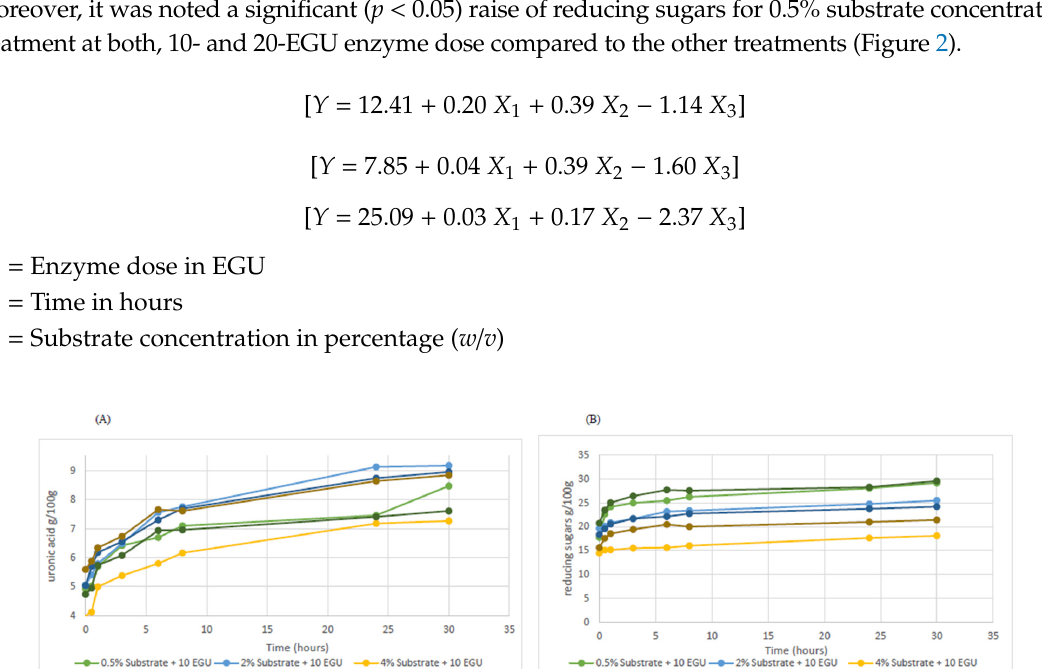
Figure 2. Determination of ( A ) uronic acids and ( B ) reducing sugars released from apple by-product during enzymatic treatment with Celluclast ® at atmospheric pressure. Data are expressed as g/100 g dry material.